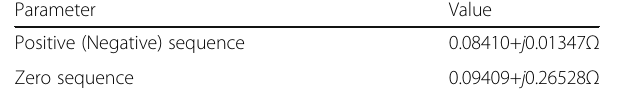
Table 1 Sequence parameters of the μ Grid circuit under protection Parameter